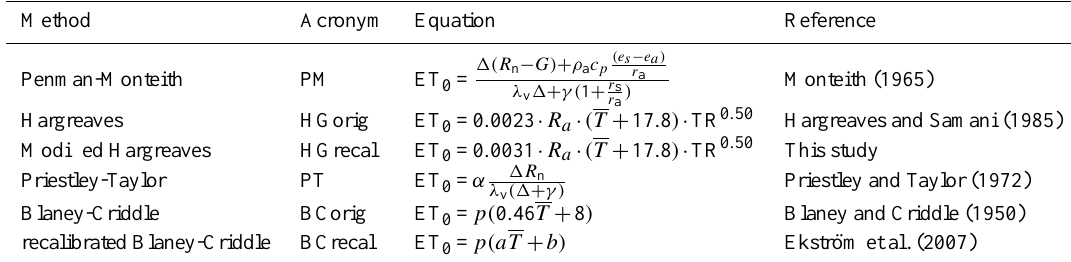
Table 2. Potential evaporation equations.